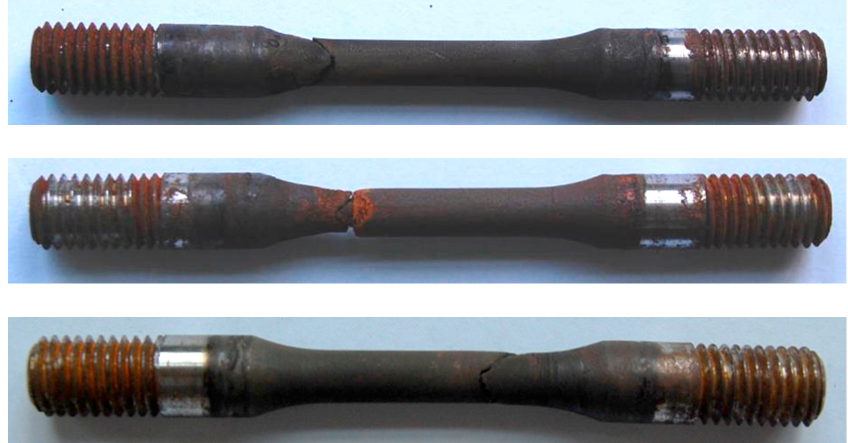
Figure 6. SSC evaluation test specimens of steel A.